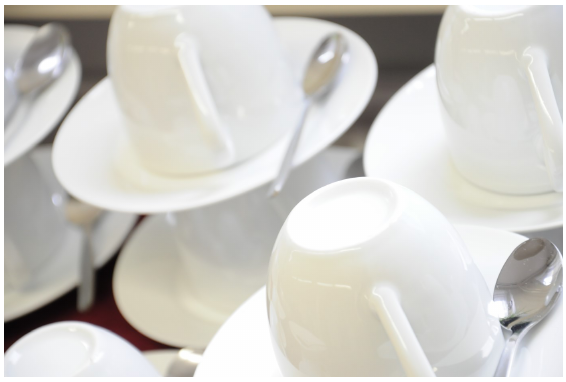
Figure 4 Coffee breaks are more heavily regulated than one might